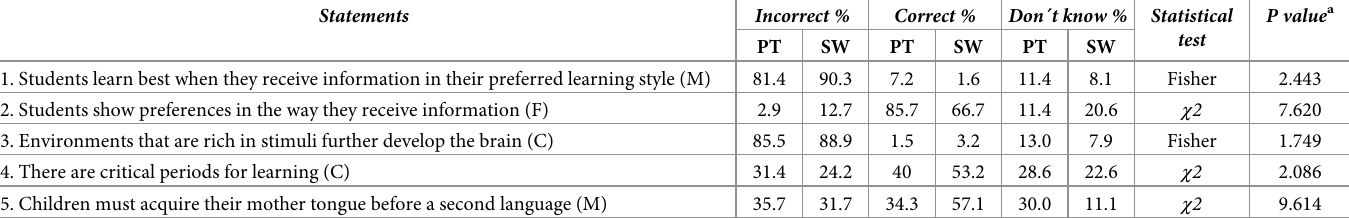
Table 2. Portuguese and Swedish teachers’ answers concerning myth/fact statements (N =